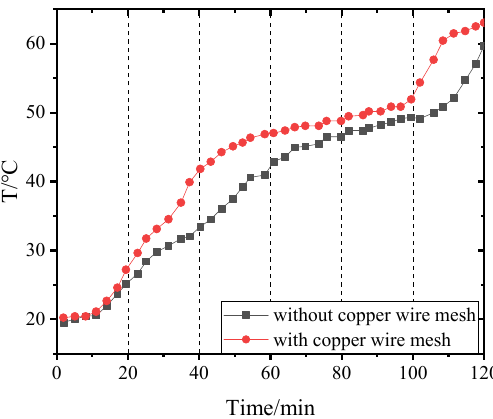
Figure 20. Temperature of point 3 in PCM-2 changing with time.